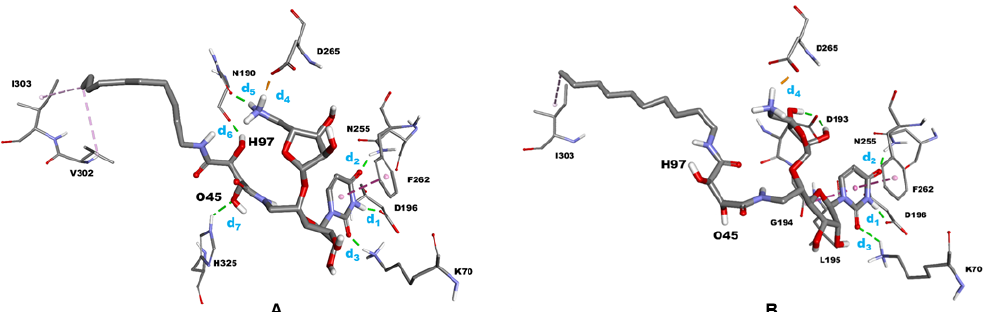
Figure 8. Ligand-binding mode from MD simulations in model 6OYH: ( A ) for compound ( S,S )- 3a and ( B ) for compound ( R,R )- 3b . Significant distances measurement (d1–d7) are indicated. For 2D interactions, see Supplementary Materials Figure S4.